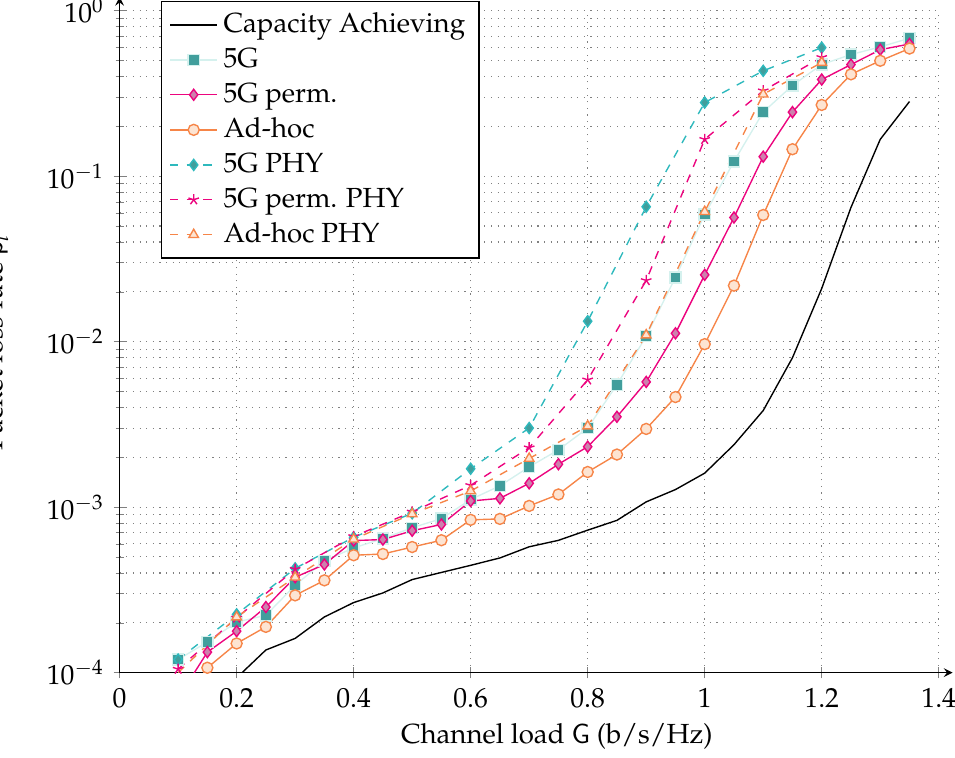
Figure 9. Dashed: PLR vs. channel load G for the asynchronous RA protocol with replicas protected by different ( 960,480 ) LDPC codes, as a result of physical layer simulations. Solid: curves from Figure 8 assuming the abstracted physical layer. The 5G corresponds to the ensemble with base matrix B 5G . The 5G perm. corresponds to the ensemble with base matrix B π with base matrix B A